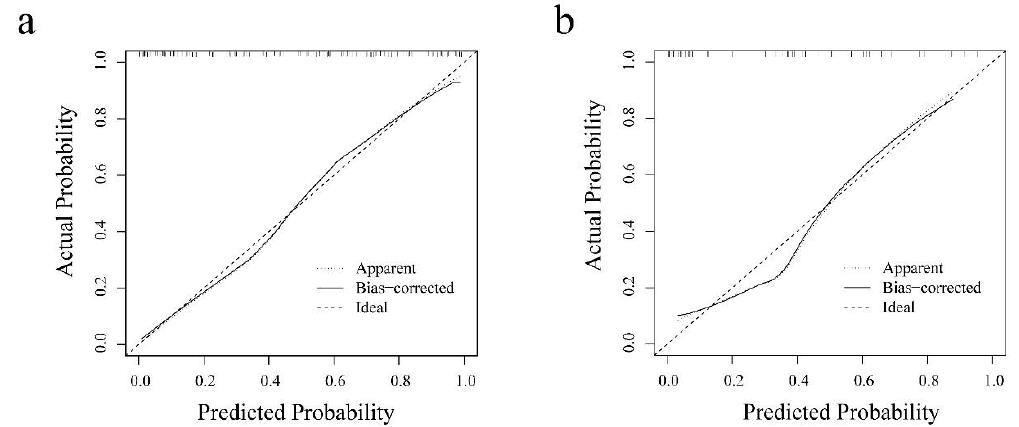
Figure 7. Calibration curves of the radiomics nomogram in each cohort. ( a ) Calibration curve of the radiomics nomogram in the training cohort. ( b ) Calibration curve of the radiomics nomogram in the validation cohort.